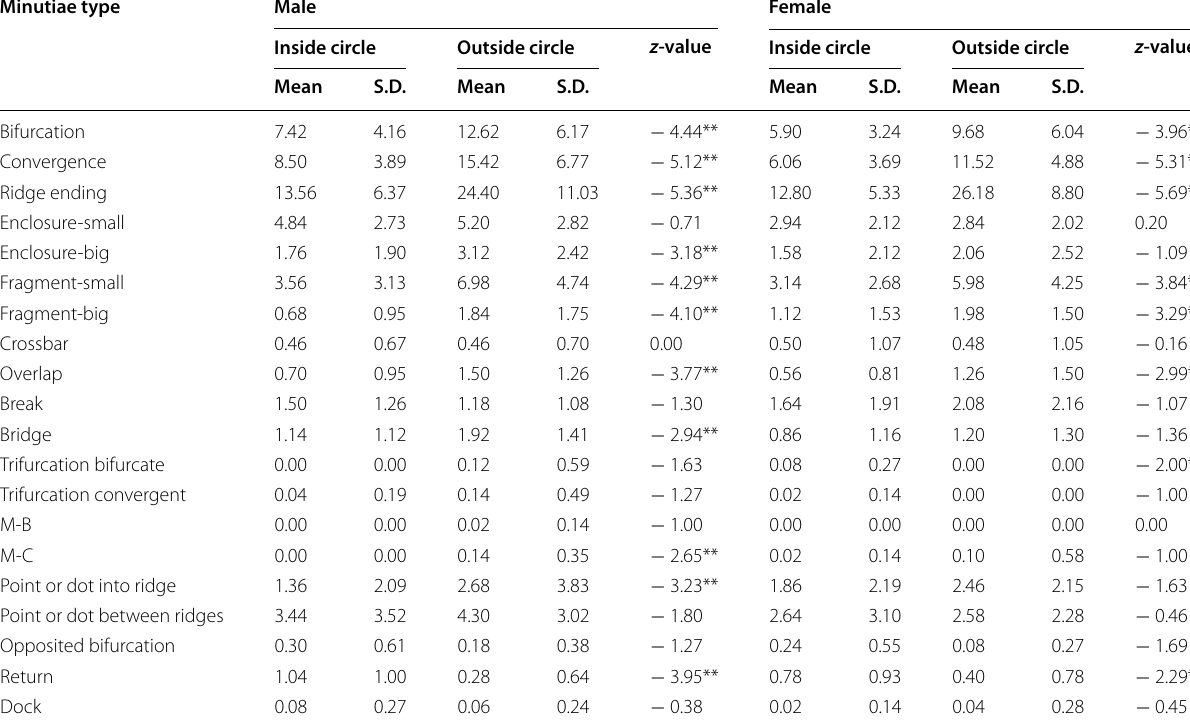
Level of significance p < 0.01**, p <